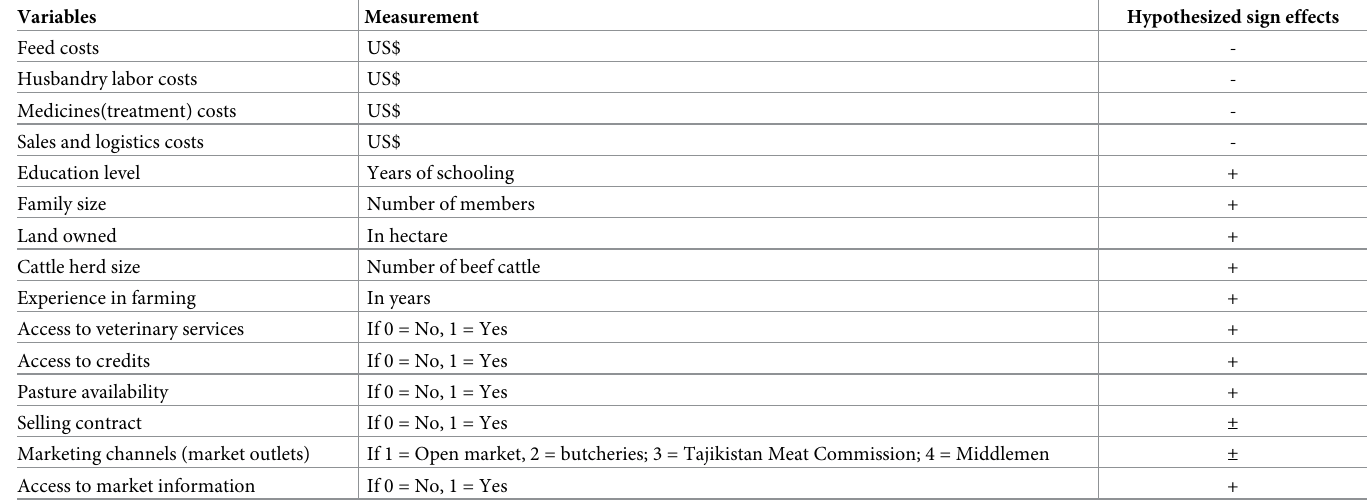
Table 2. The pre-hypothesized sign effects of the independent variables on beef cattle